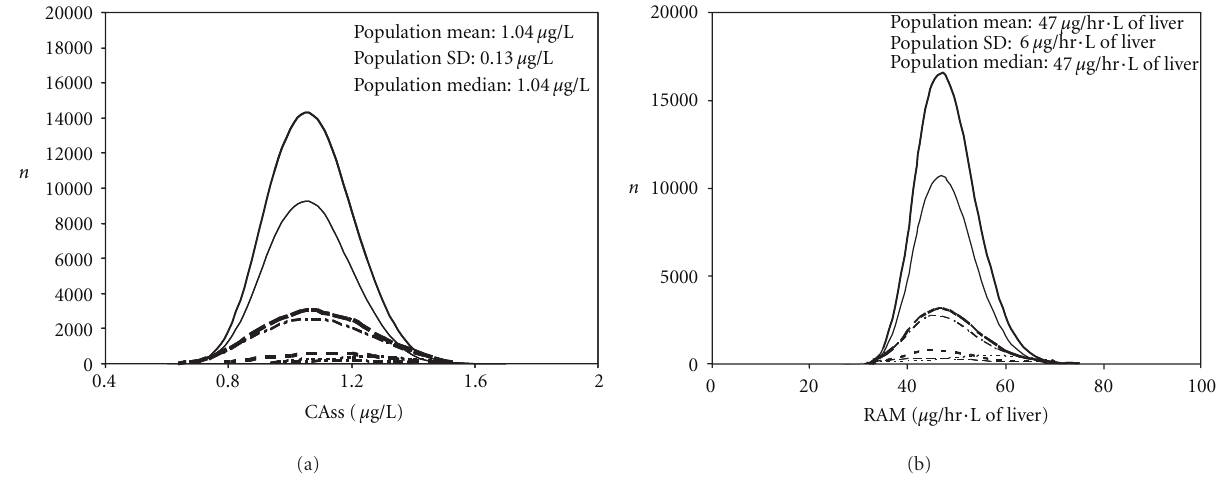
Figure 1: Distributions of individual values obtained for CAss (a) and RAM (b) in each subpopulation within the whole Canadian population for constant inhalation exposure to benzene. From top to bottom, the distributions are shown for the entire Canadian population (thick — ), adults (—), children and adolescents ( —– ), elderly (– · – · –), toddlers ( ––- ), pregnant women (-------), infants (- · - · - · -), and neonates (indistinguishable).